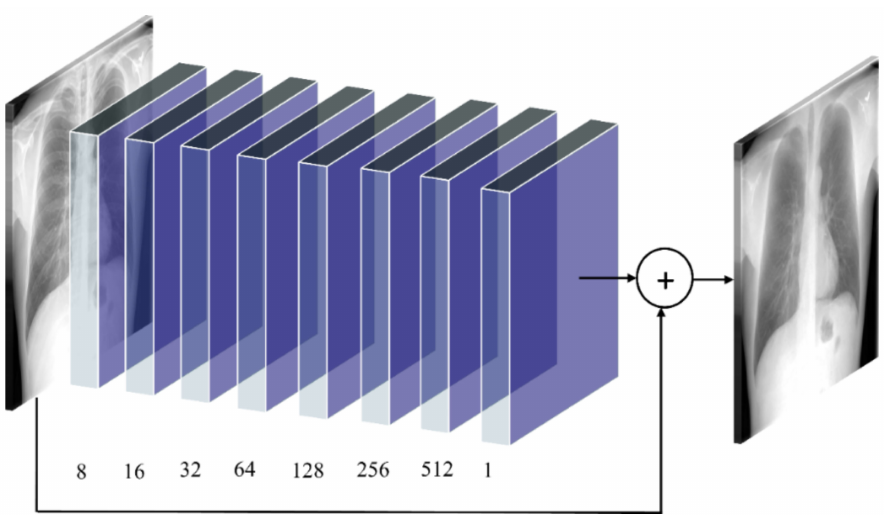
Figure 3. The architecture of the proposed RL–BS